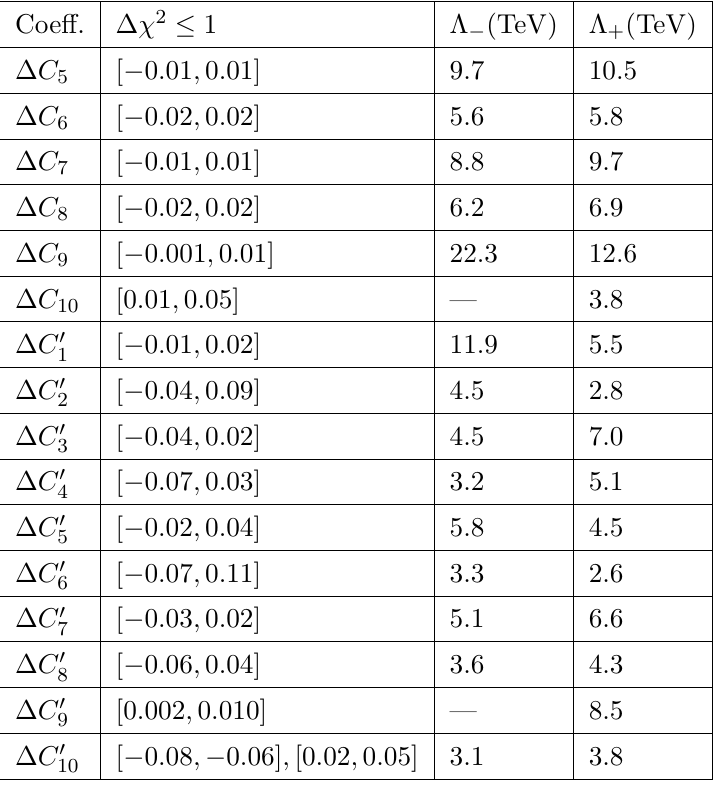
Table 5. Allowed 1 (cid:27) ranges from all observables combined and corresponding bounds on BSM